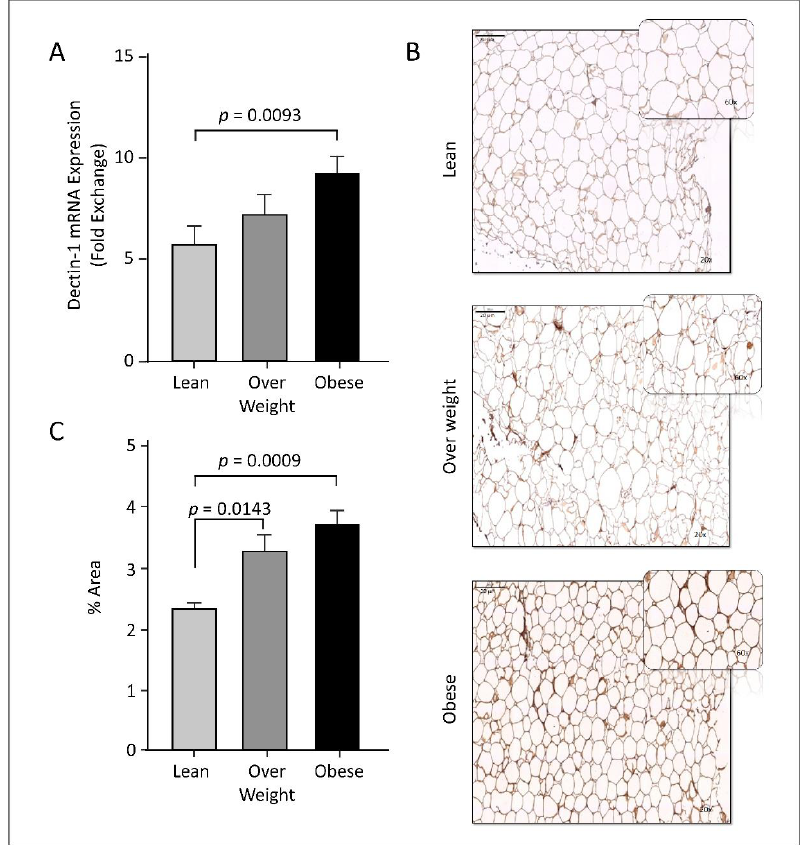
Figure 1. Upregulation of adipose tissue (AT) dectin-1 gene and protein expression in obesity. ( A ) Dectin-1 gene expression was assessed in AT using qRT-PCR in 59 individuals grouped into lean, overweigh and obese based on their BMI, as described in Materials and Methods. Dectin-1 tran- scripts expression was significantly increased in obese compared with lean adipose tissue ( p = 0.0093). ( B ) Immunohistochemistry (IHC) analysis was performed to determine dectin-1 protein ex- pression using five AT sections isolated from 5 participants per-group (Leans: 3 females + 2 males; Overweight: 1 females + 4 males; Obese: 4 males + 1 female). Screening of all IHC sections revealed no gender differences. Representative images for AT dectin-1 protein expression (magnification, 20x; enlarged area of image in top right corner, magnification, 60×) in obese, overweight, lean indi- viduals. ( C ) Integrated optical density (IOD) divided by the adipocytes area was used to quantify dectin-1 protein expression in IHC sections of the adipose tissue samples from lean, overweight, and obese individuals. The data (mean ± SEM) show elevated dectin-1 protein expression in over- weight ( p = 0.0143) and obese ( p = 0.0009) individuals compared to lean. Regarding IHC. 3.3. Increased AT Dectin-1 Gene Expression in Obesity Correlates with the Metabolic and Immune Markers AT gene expression of dectin-1 was found to correlate positively with the clinical in- dicators of obesity including BMI (r = 0.3557, p = 0.007; Figure 2A) and body fat percentage (r = 0.340, p = 0.017; Figure 2B), indicating its strong association with obesity. In our cohort, AT dectin-1 transcripts expression was also found to be positively associated with systemic inflammatory biomarkers, including serum CRP (r = 0.363, p = 0.023; Figure 2C) and